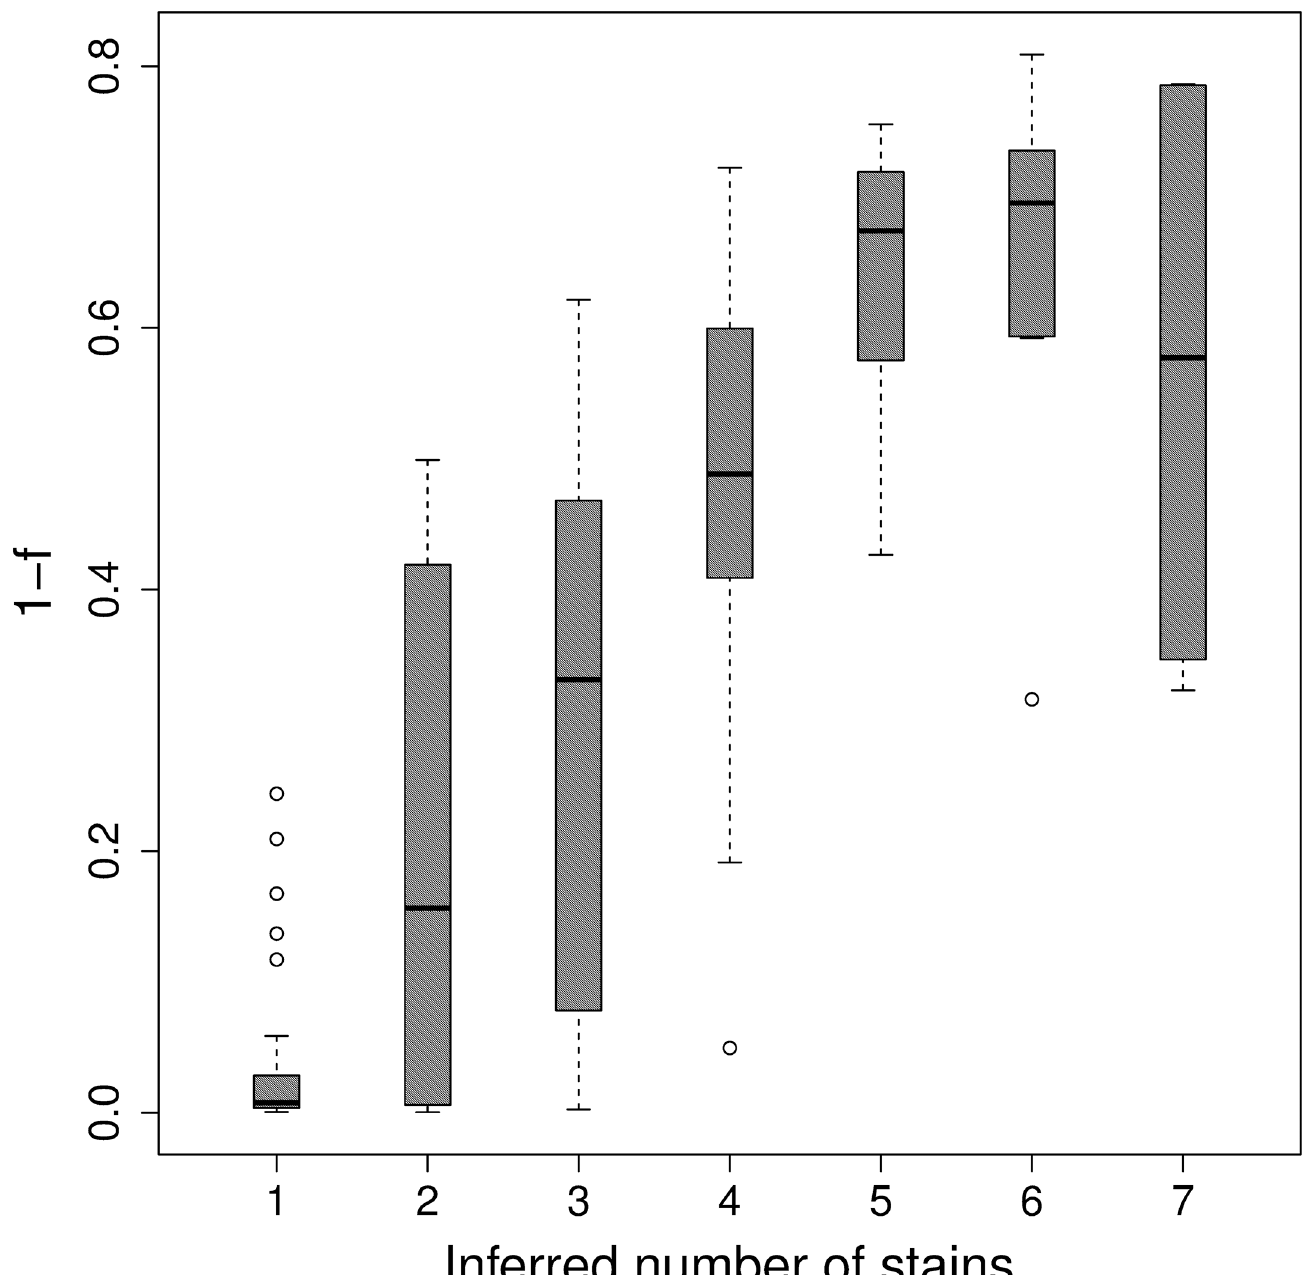
Fig 7. Number of strains by F-statistic. Boxplot of the inbreeding coefficient (1 − F is ) for each sample grouped by the MAP number of inferred strains.